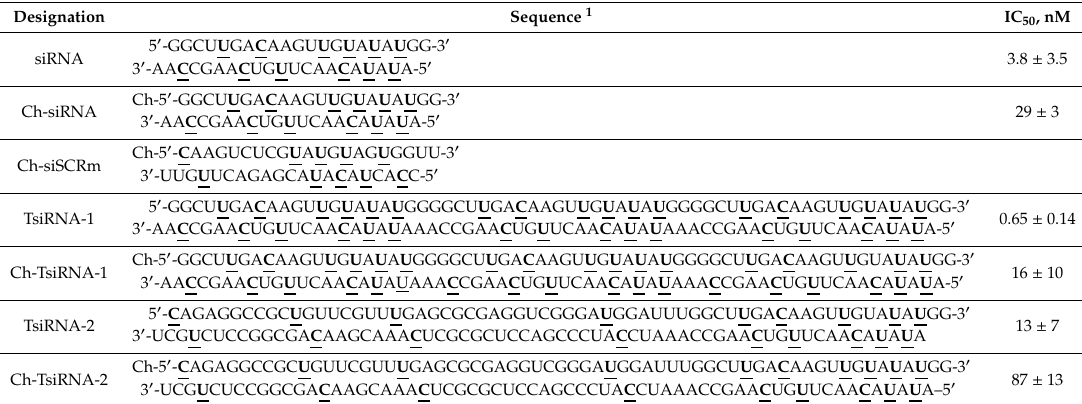
Table 1. Sequences of siRNAs and calculated IC 50 values for MDR1-GFP gene silencing after transfection into KB-8-5-MDR1-GFP cells by Lipofectamine 2000.